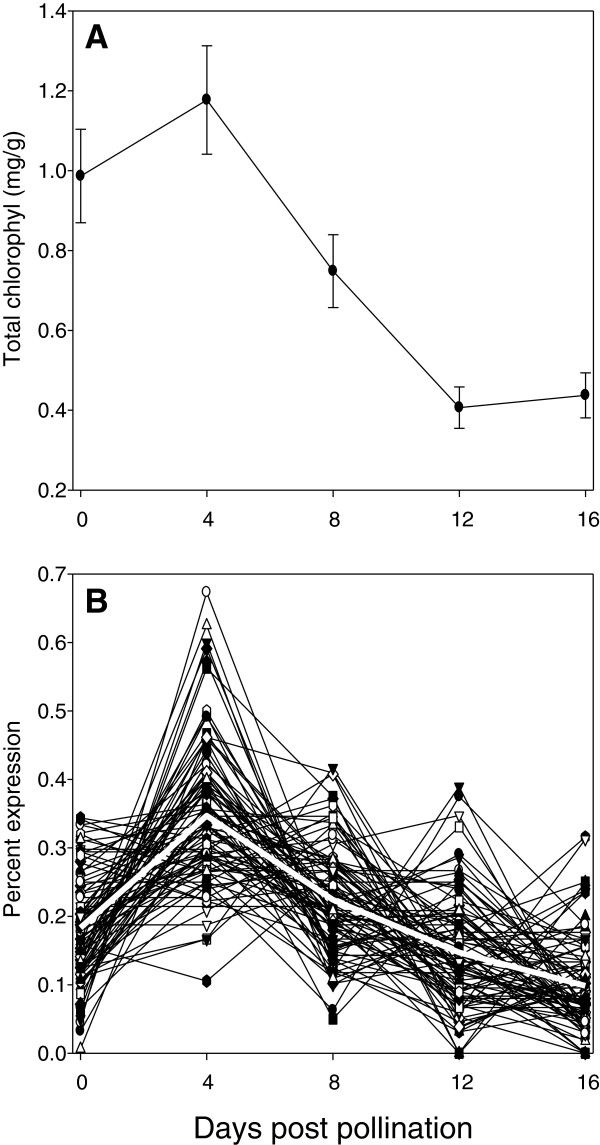
Chlorophyll content and expression of chlorophyll and chloroplast-related transcripts in relationship to fruit age. (A) Chlorophyll content. (B) Expression of chlorophyll and chloroplast-related transcripts in relationship to fruit age. Gene expression is plotted as percent of total expression observed for that transcript at each age. The heavy white line represents average percent gene expression at each age for the 91 genes (Supplemental file 2) with homologs in Arabidopsis annotated to be associated with chlorophyll or chloroplasts